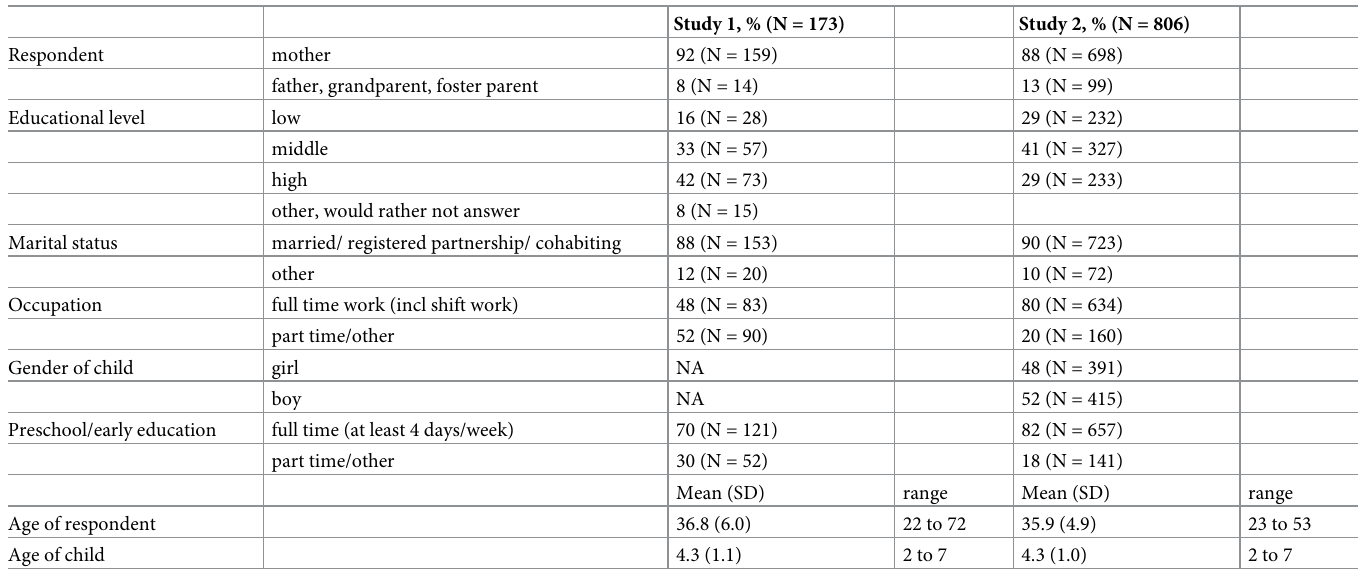
Table 1. Descriptive characteristics of the two study samples.